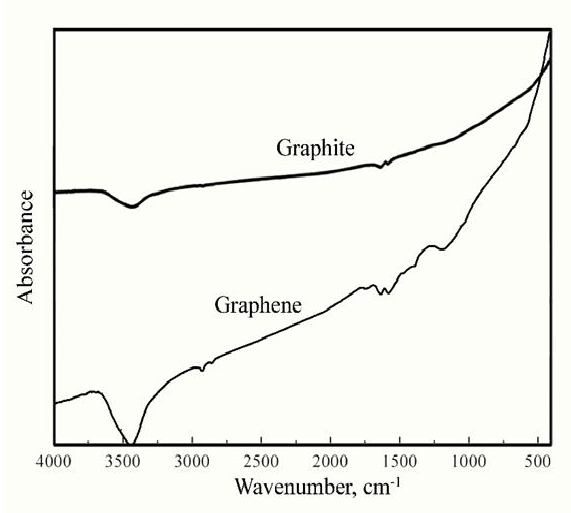
Fig. 1. FT-IR spectra of graphite and graphene.